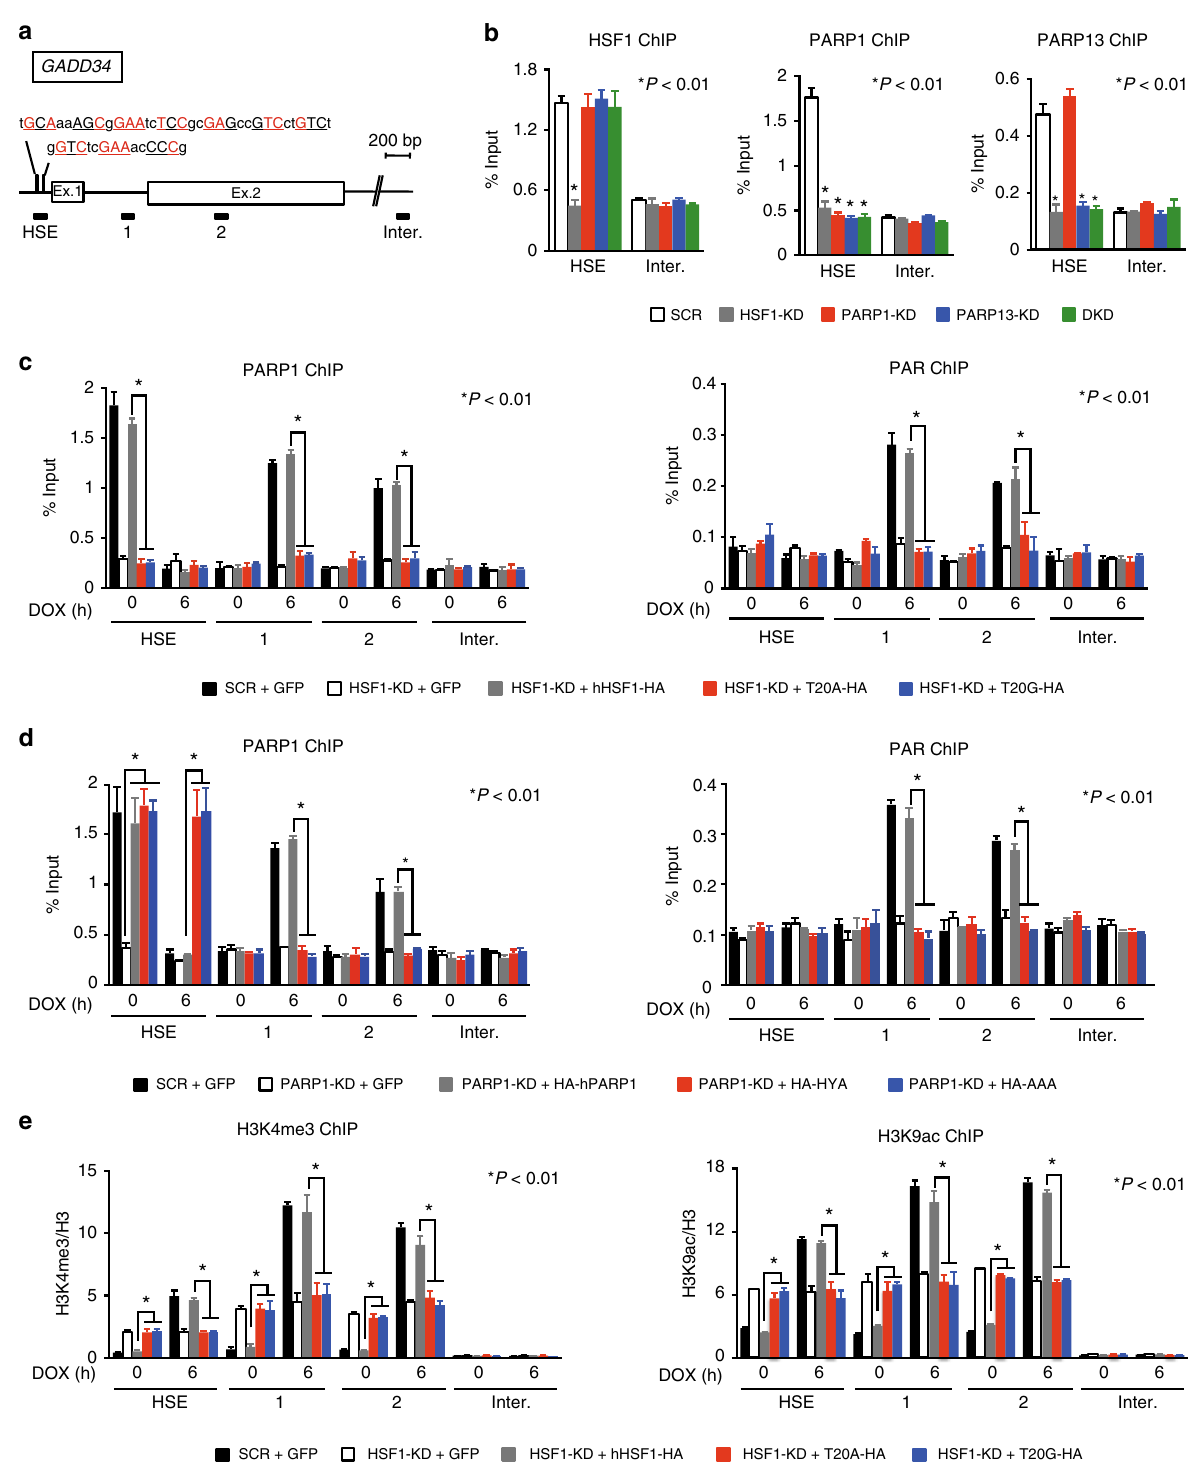
Fig. 4 HSF1 – PARP13 promotes PARP1 redistribution and chromatin opening. a Schematic view of HSEs in the promoter of the GADD34 gene. Bars indicate ampli fi ed DNA regions by ChIP-qPCR. Exons and HSE sequences are shown. Consensus nGAAn units are underlined and conserved sequences are highlighted in red. b Constitutive occupancy of HSF1, PARP1, and PARP13 on the HSEs. ChIP-qPCR was performed after each knockdown ( n = 3). Double knockdown (DKD) indicates knockdown of both PARP1 and PARP13. c Occupancy of PARP1 and PAR on the GADD34 locus in cells expressing each hHSF1 mutant. ChIP-qPCR on the HSE and each gene locus (region 1 or 2) was performed before and after DOX treatment ( n = 3). d Occupancy of PARP1 and PAR on the GADD34 locus in cells expressing each hPARP1 mutant. ChIP-qPCR was performed before and after DOX treatment ( n = 3). e Levels of active chromatin marks on the GADD34 locus in cells expressing each hHSF1 mutant. ChIP-qPCR was performed before and after DOX treatment ( n = 3). Mean ± s.d. is shown. Asterisks indicate P < 0.01 by Student ’ s t